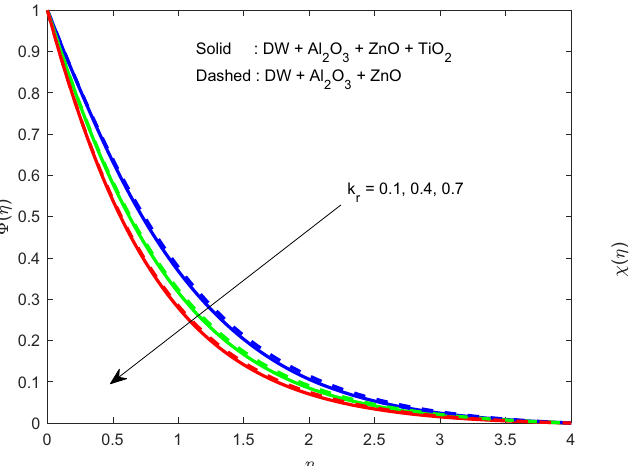
Figure 10: Increasing e ff ects of k r on Φ ( η ) .